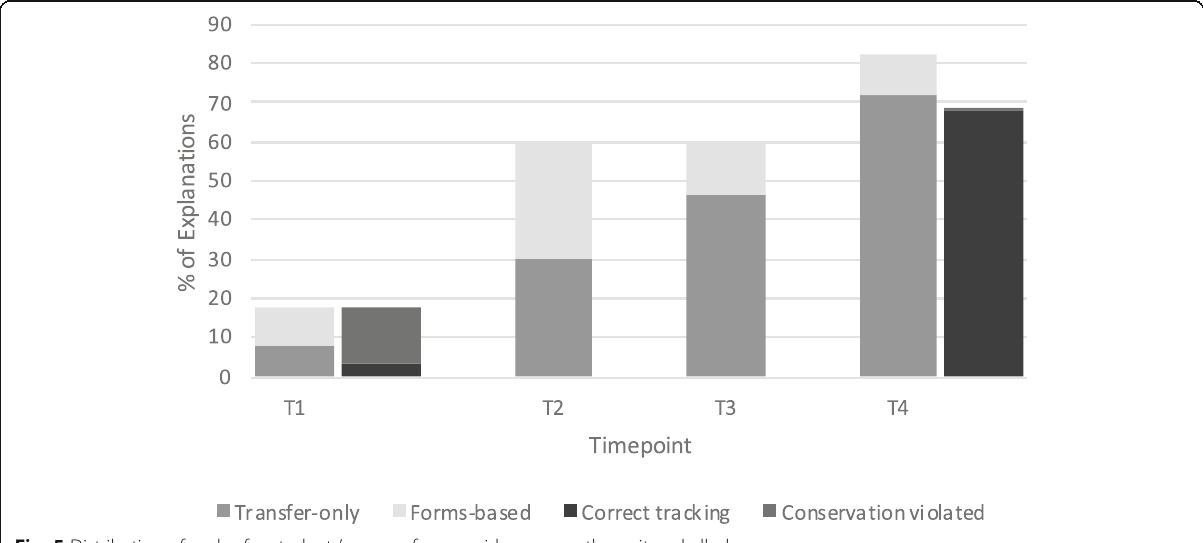
Fig. 5 Distribution of codes for students ’ usage of energy ideas across the unit and all